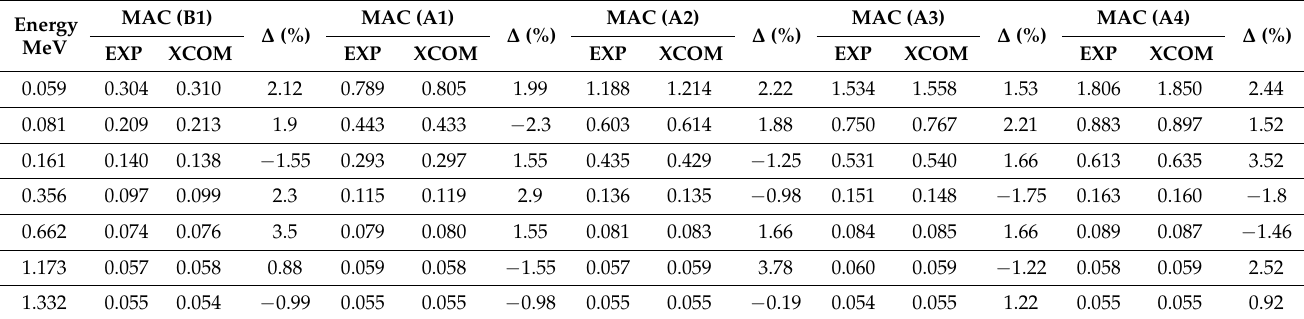
Table 1. The measured and theoretical MAC for the fabricated